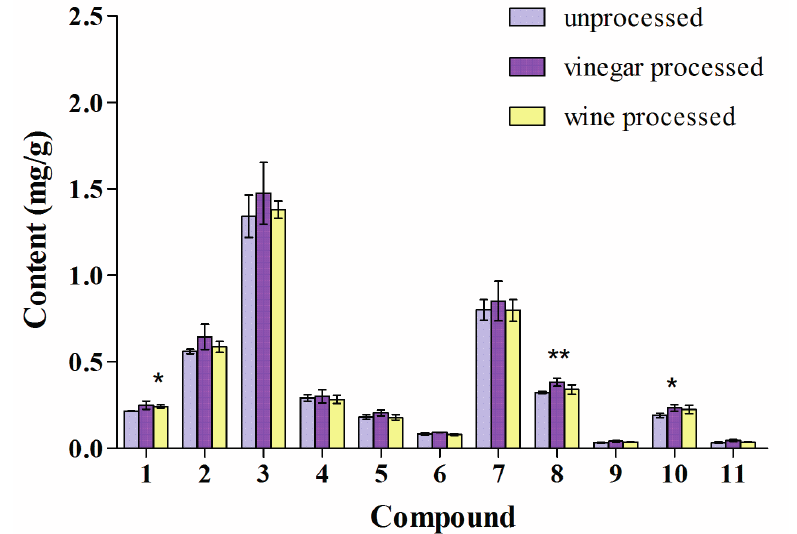
Figure 5. Alkaloid content of the water decoction of Corydalis Rhizoma. Values are mean ± SD, n = 3, RSD < 13%. ** p < 0.01, * p < 0.05 of processed against unprocessed Corydalis Rhizoma.